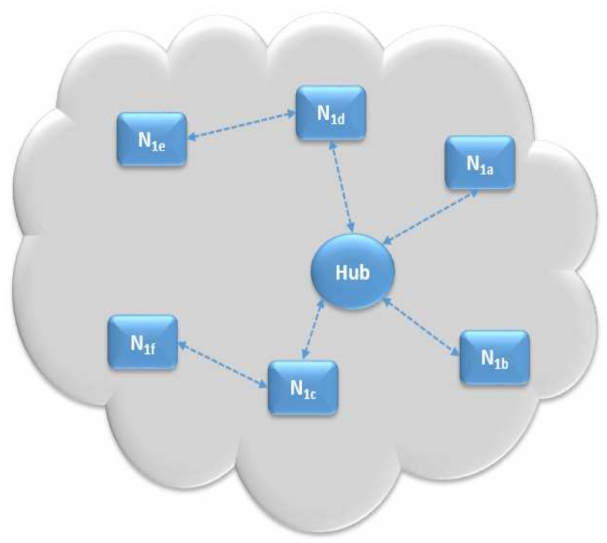
Figure 5. One hop star WBAN topology.